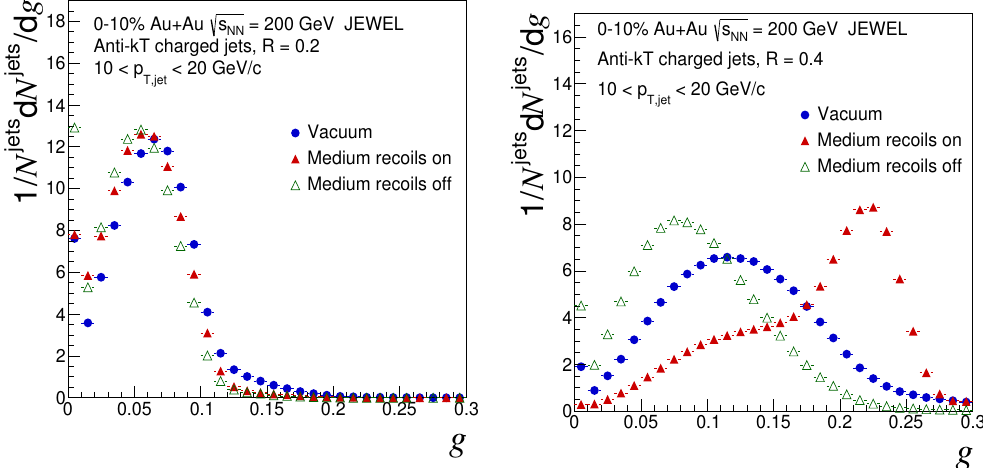
Figure 3. Girth for jets with p T of 10–20 GeV/ c and R = 0.2 ( left ) and R = 0.4 ( right ) in central Au+Au √ s NN = 200 collisions at